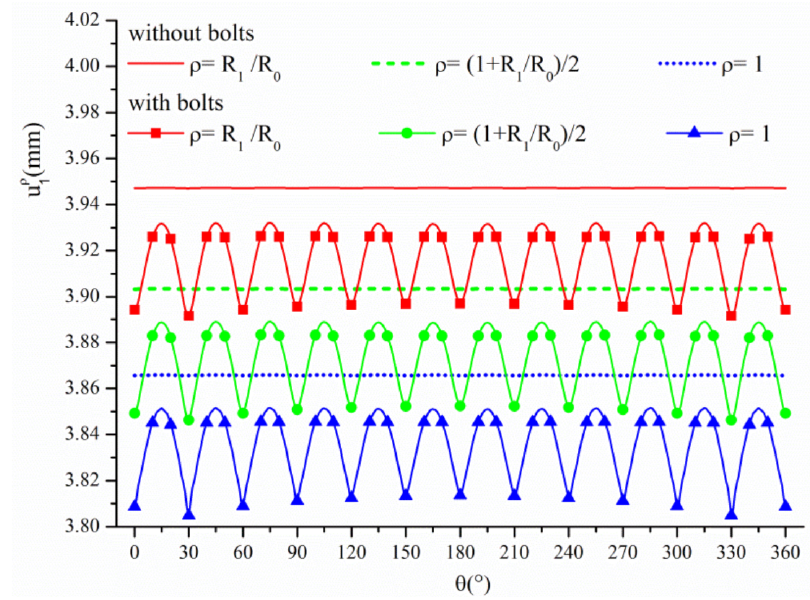
Figure 8. The effect of bolts on the radial displacement of the